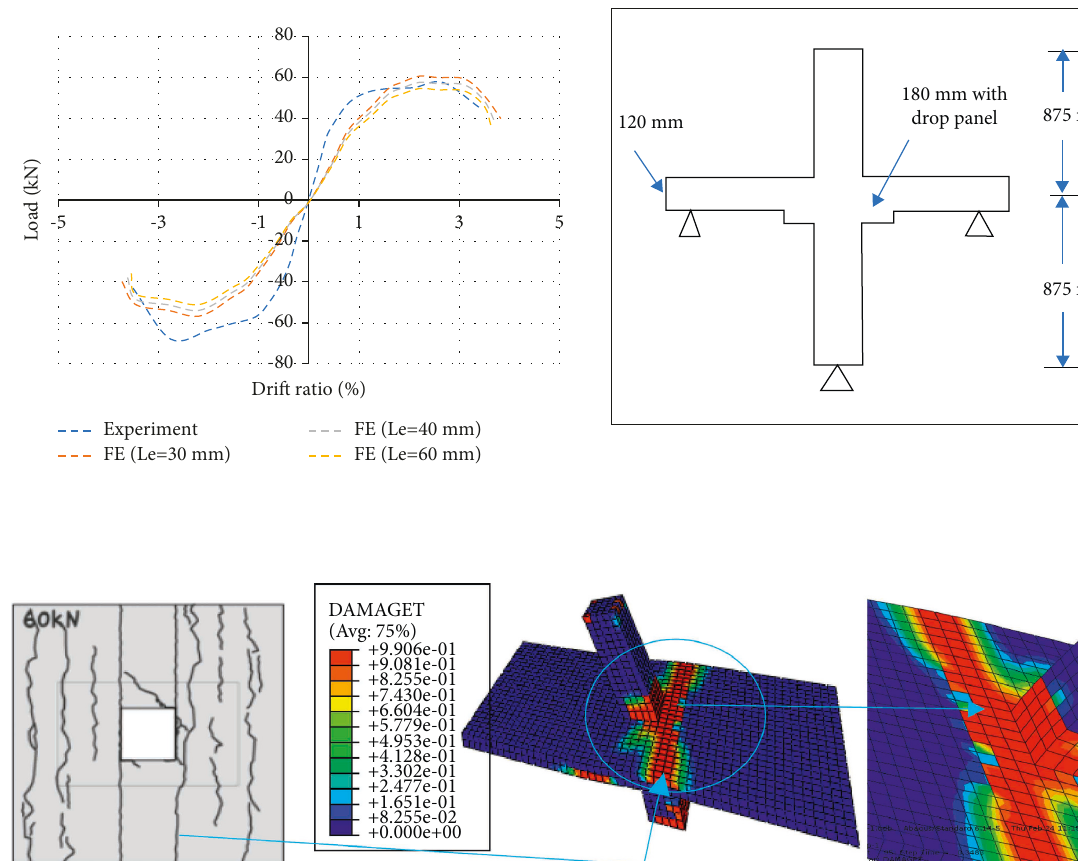
Figure 8: Comparison of FE simulation and experimental result based on mesh size sensitivity.